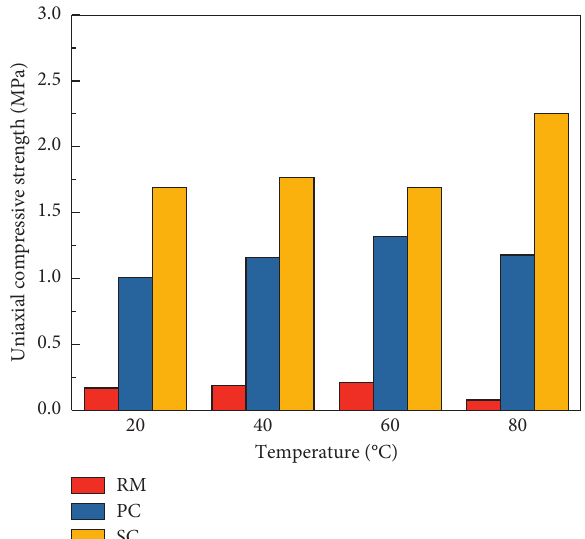
Figure 4: Effect of binder type and temperature on the UCS of CPB after curing for 8